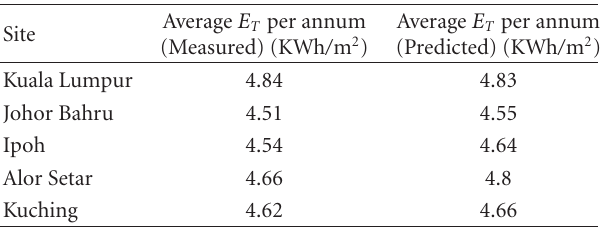
Table 2: Annual global solar radiation averages for five di ff erent sites in